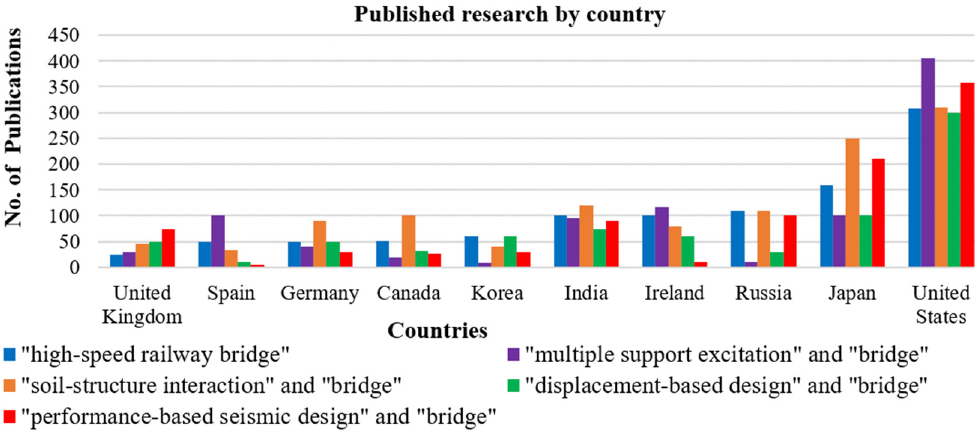
Figure 5. Bar chart presentation of published research by country for bridge design.